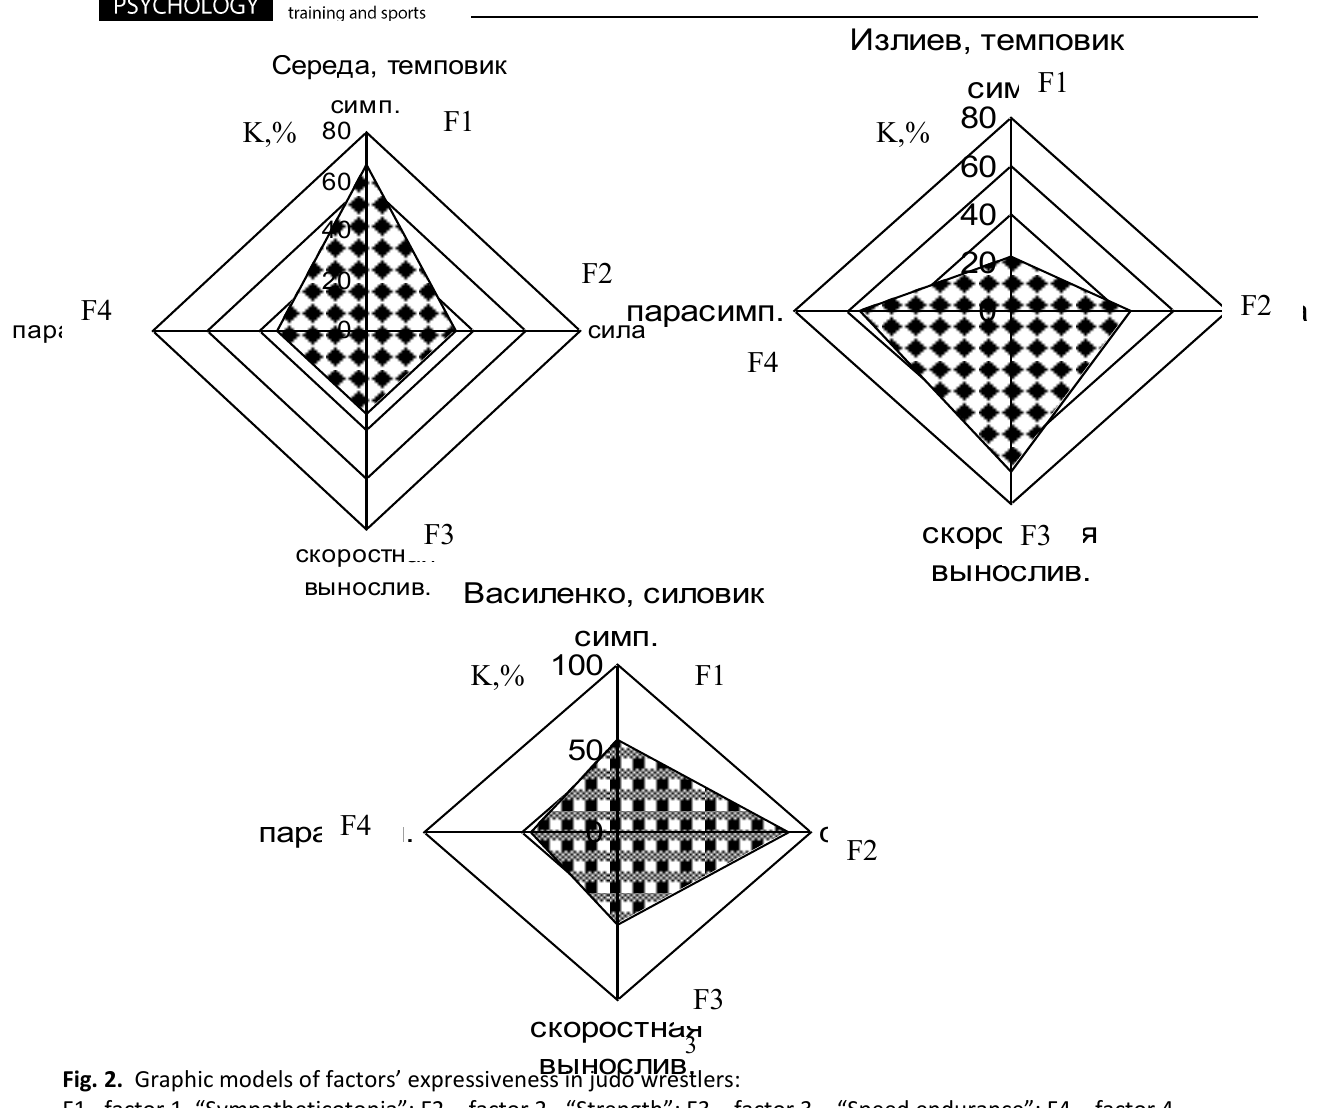
Fig. 2. Graphic models of factors’ expressiveness in judo wrestlers: F1 –factor 1, “Sympatheticotonia”; F2 – factor 2– “Strength”; F3 – factor 3 – “Speed endurance”; F4 – factor 4, “Para-sympatheticotonia”; K – individual expressiveness of factor, %; 1 – Judo wrestlers - B»; 2 – judo wrestlers - «C»; 3 – judo wrestlers -